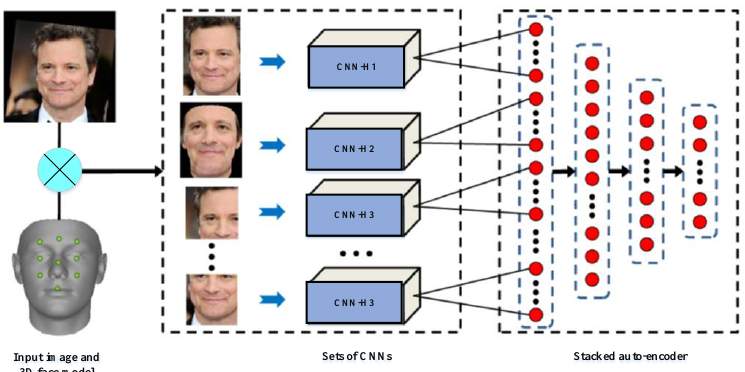
Figure 12. Flowchart of the proposed multimodal deep face representation (MM-DFR) technique [95]. CNN, convolutional neural network.